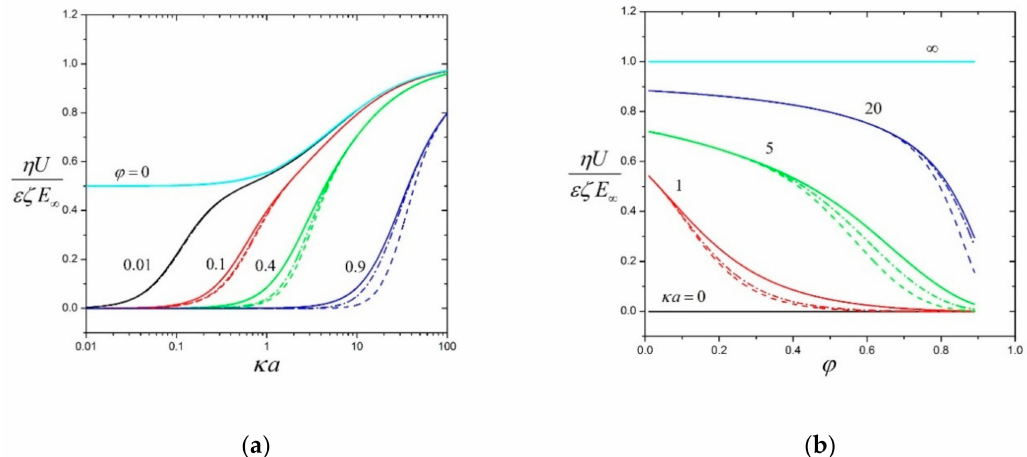
Figure 6. The normalized electroosmotic velocity η U / εζ E ∞ of an electrolyte solution through a fibrous medium calculated from Equation (26b) for the Kuwabara/Levine-Neale cell model versus the parameters κ a ( a ) and ϕ ( b ). The solid, dot-dash, and dashed curves represent the cases of the charge regulation parameter La equal to 0, 5, and ∞ ,